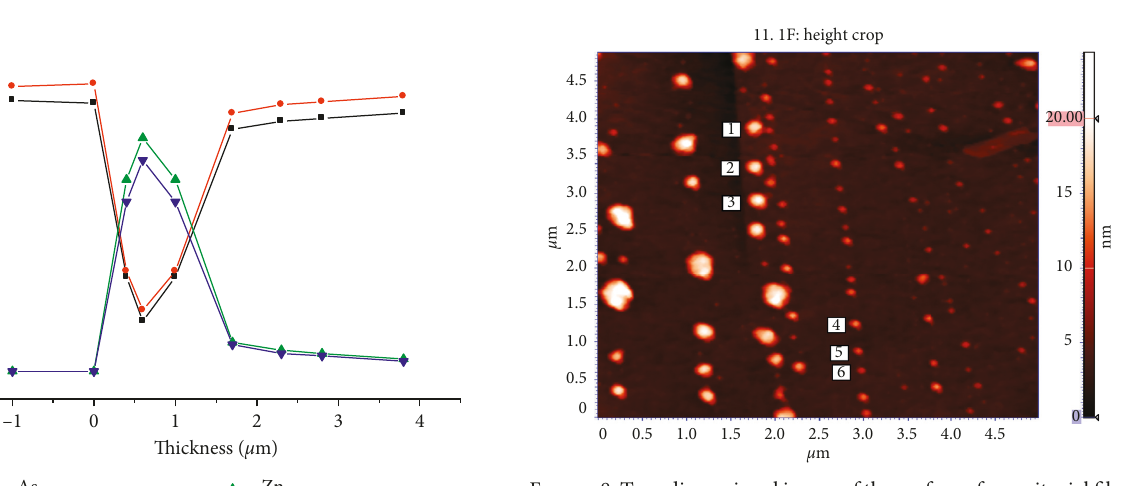
Figure 8: Two-dimensional image of the surface of an epitaxial film of a solid solution (GaAs) 1 − x (ZnSe) x , obtained by using an atomic force microscope. Figure 7: The distribution profiles of Ga, As, Zn, and Se atoms in